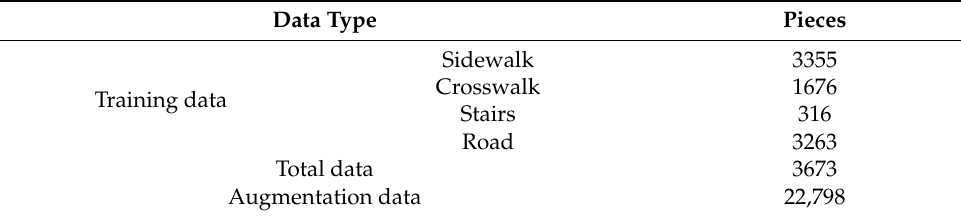
Table 1. The data distribution.